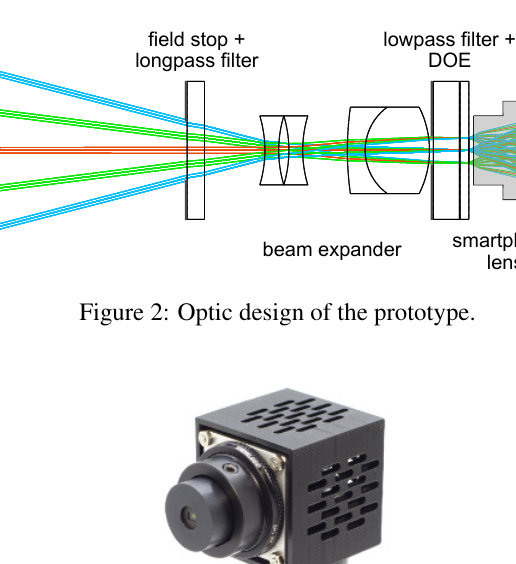
Figure 4: Pre-processed sensor image and reconstruction results. The shown spectra are averaged over a 5 x 5 pixel area. The ground truth is shown in dashed black lines. Figure 3: Assembled prototype.